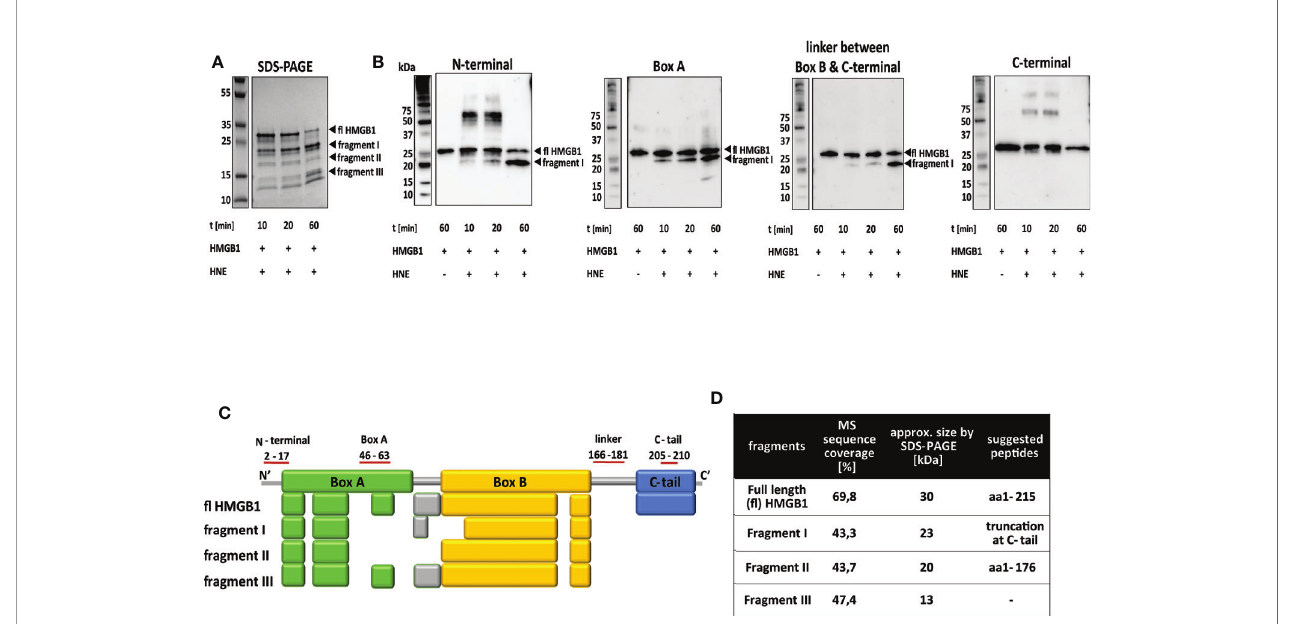
FIGURE 2 | HNE cleaves HMGB1 at the C-terminal part and within box A. (A) Left panel: SDS-PAGE showing full length HMGB1. Right panel: SDS-PAGE showing the rapid cleavage by HNE over time. A larger fragment (I) appeared early and increased in strength during the studied time frame. A smaller fragment (III) also increased in strength during the studied time frame while an intermediate-sized fragment (II) appeared equal in strength throughout the cleavage reaction. (B) Western blotting demonstrating the presence of different protein regions in the HNE-generated HMGB1 fragments. Fragment I contained both the N-terminal and the box A epitopes but not the C-terminal tail epitope. A lower Mw fragment with an apparent size of 15 kDa was detected in Western blotting with the antibody against Box A but with none of the other antibodies used. (C) Gel bands of HMGB1 fragments I to III were analyzed by mass spectrometry and the resulting peptides were compared to peptides detected in the full length protein. Colored boxes refer to the functional domains of HMGB1 in which peptides could be identi fi ed (Box A: Green, linker region: grey, box B: yellow, C-terminal tail: blue). (D) Suggested cleavage sites based on data in (A – C) together with literature and database